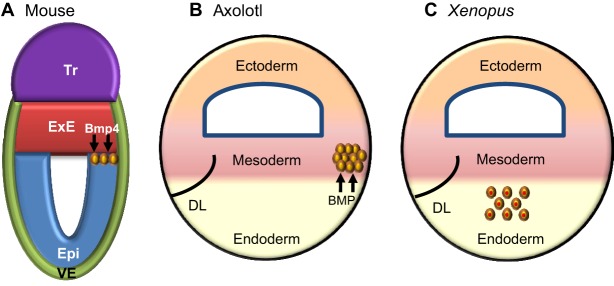
Primordial germ cell specification in mice, axolotls and frogs. (A,B) In mice (A) and axolotls (B), BMP is a key inductive molecule required for the specification of germ cell precursors (Lawson et al., 1999; Chatfield et al., 2014). (C) In Xenopus, germ plasm components inherited from the egg are passed to a group of cells in the endoderm of the developing embryo that become PGCs (Blackler, 1962). DL, dorsal lip; Epi, epiblast; ExE, extra-embryonic ectoderm; Tr, trophectoderm; VE, visceral endoderm. Yellow circles depict primordial germ cell precursors. In the case of Xenopus, the red centre depicts the germ plasm.